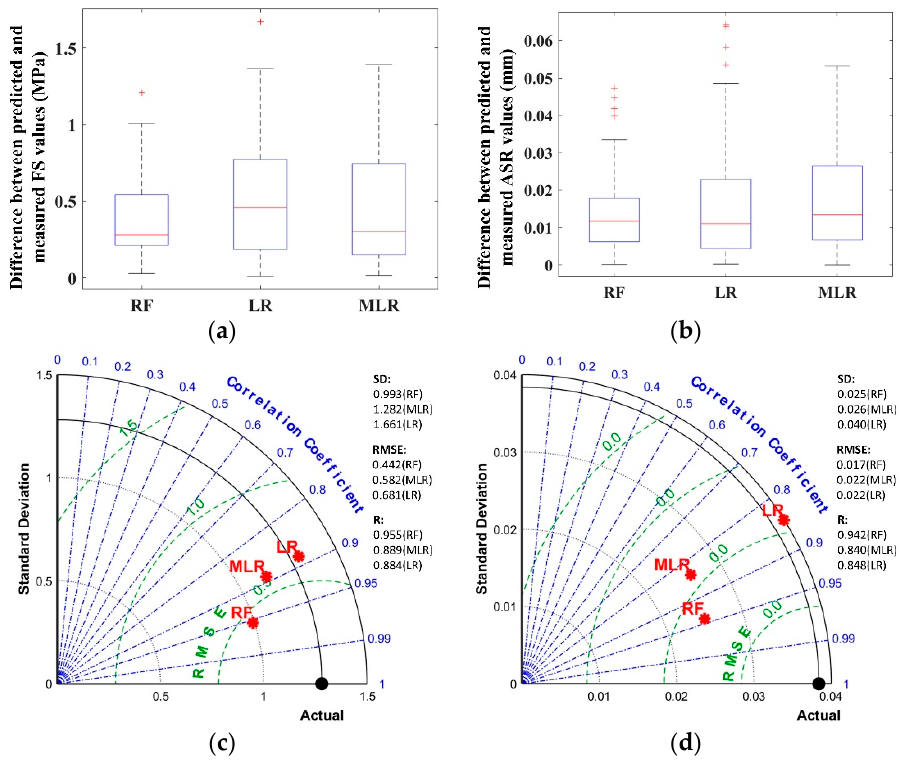
Figure 13. Performance evaluation of three models by ( a ) boxplot of FS modelling, ( b ) boxplot of ASR modelling, ( c ) Taylor diagram of FS modelling, and ( d ) Taylor diagram of ASR modelling.